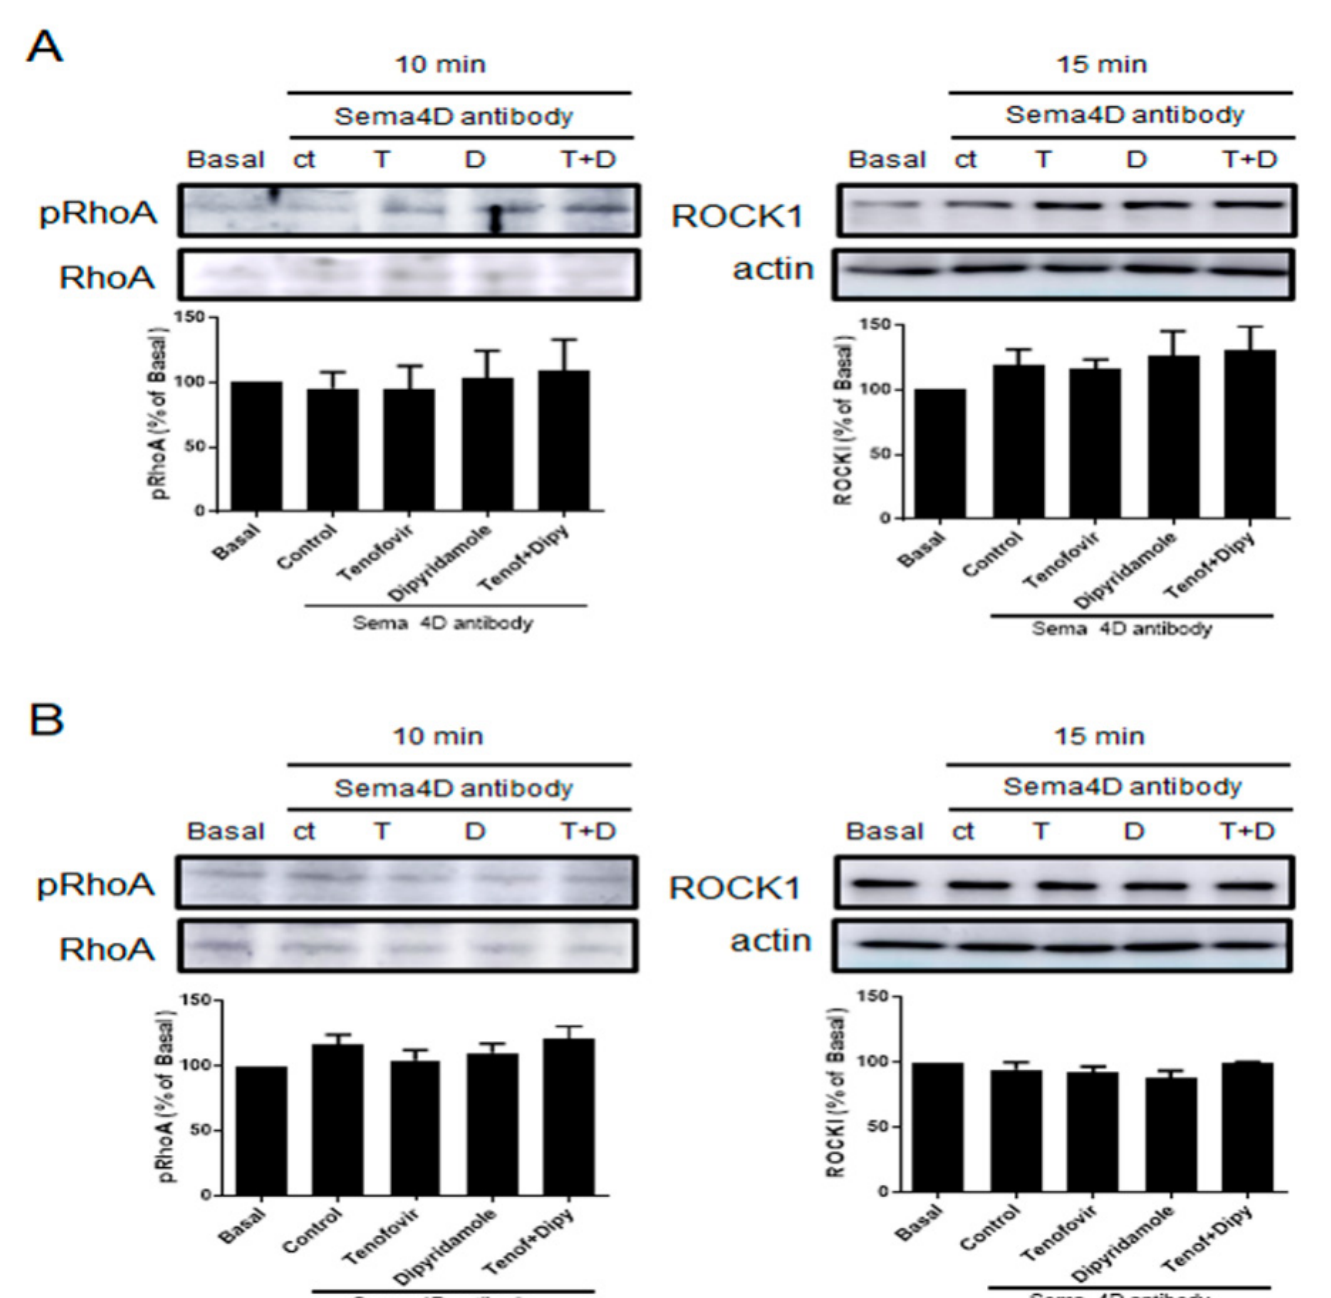
Figure 8. Phosphorylation of RhoA and ROCK1 activation by tenofovir in osteoblast-osteclast co-culture is avoided in the presence of Sema4D antibody. ( A ) pRhoA and ROCK1 expression were studied in WT osteoblast precursors in co-culture the presence of tenofovir at 1 µ M and dipyridamole at 1 µ M in combination with Sema4D antibody 10 ng/mL. ( B ) pRhoA and ROCK1 expression were studied in A2AKO osteoblast precursors in co-culture the presence of tenofovir at 1 µ M and dipyridamole at 1 µ M in combination with Sema4D antibody 10 ng/mL. To normalize for protein loading, the membranes were reprobed with RhoA or actin.